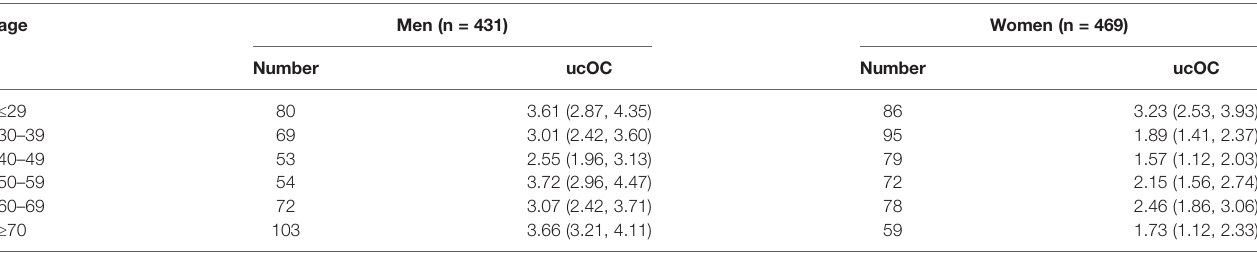
BMI,bodymassindex;BMD,bonemineral density;ALP,alkalinephosphatase; ALT,alanineaminotransferase;AST,aspartateaminotransferase; UA,uricacid;BUN,bloodureanitrogen; Cr, creatinine; P1NP, procollagen type 1 N-propeptide; b -CTX, b -CrossLaps of type I collagen-containing cross-linked C-telopeptide; 25OHD, 25-hydroxyvitamin D; PTH, parathyroid hormone; ucOC, undercarboxylated osteocalcin. a Adjusted for age, BMI, Cr, and 25OHD. Signi fi cant values (p < 0.05) are presented in TABLE 2 | Means and 95% CI for the age-speci fi c measurements of ucOC in men and women. age